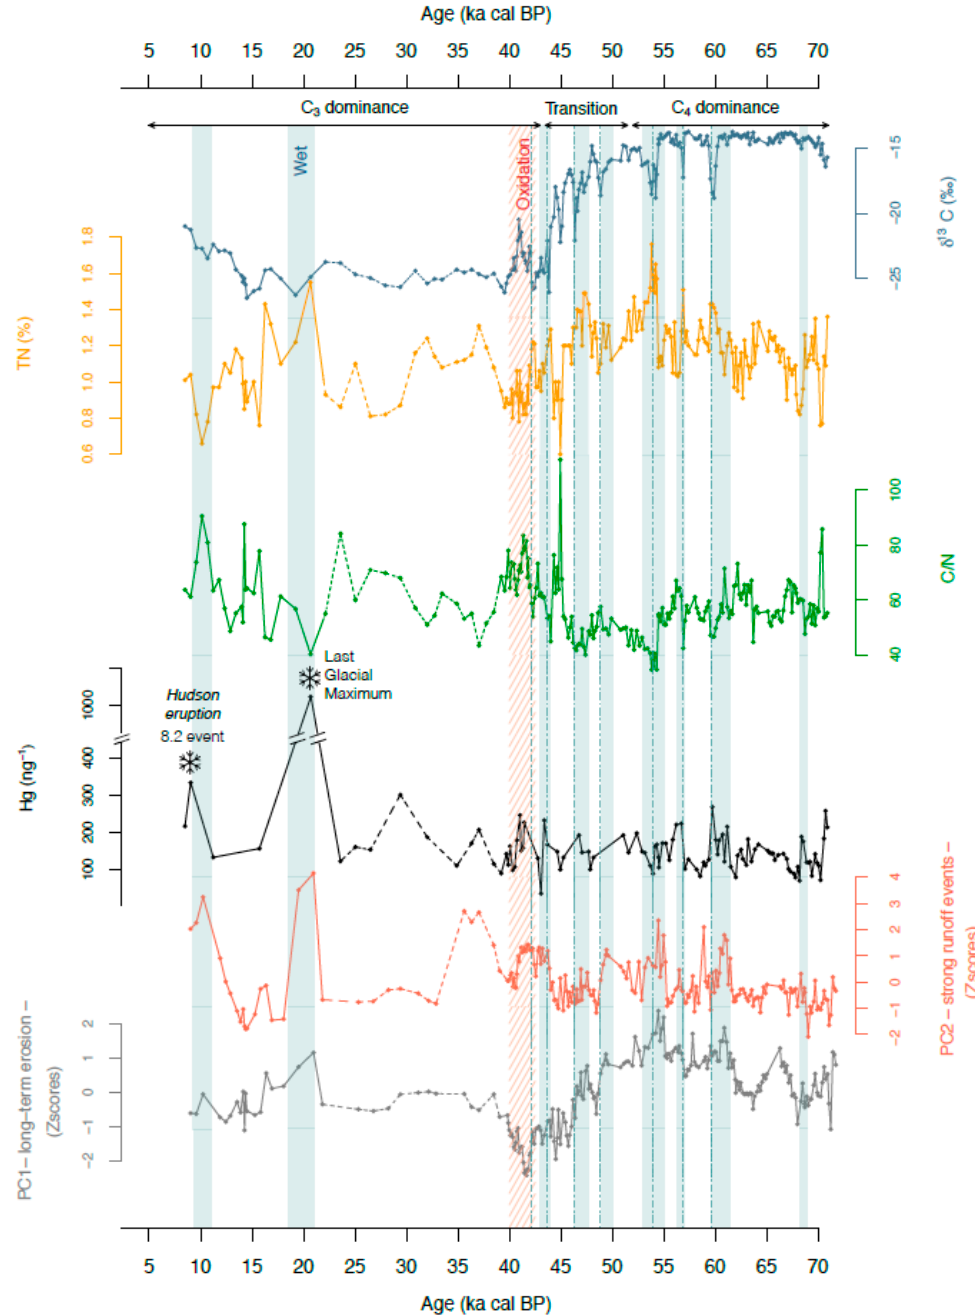
Figure 4. Mercury concentration and main proxies; from bottom to top: PC1, PC2, Hg concentration, C/N, TN and δ 13 C used to reconstruct the environment in Rano Aroi between ca. 71.0 ka BP and ca. 9.0 ka cal BP in the ARO 06 01 core. PC1 and PC2 data are from previous research [32] and represent the long-term background fluxes of inorganic particulate material and the delivery of large amounts of terrigenous particles transported during wet events, respectively. The δ 13 C (‰) general trend indicates C 3 and C 4 vegetation dominance. Wet events according to δ 13 C (‰) excursions and PC2 peaks that match with Hg concentration increases (blue bars); the dashed line indicates the position of the δ 13 C (‰) excursion in agreement with the literature (see text). A red discontinuous bar indicates a highly oxidized peat section. Discontinuous trend lines indicate sections with chronological uncertainty. Cold periods are indicated (*).